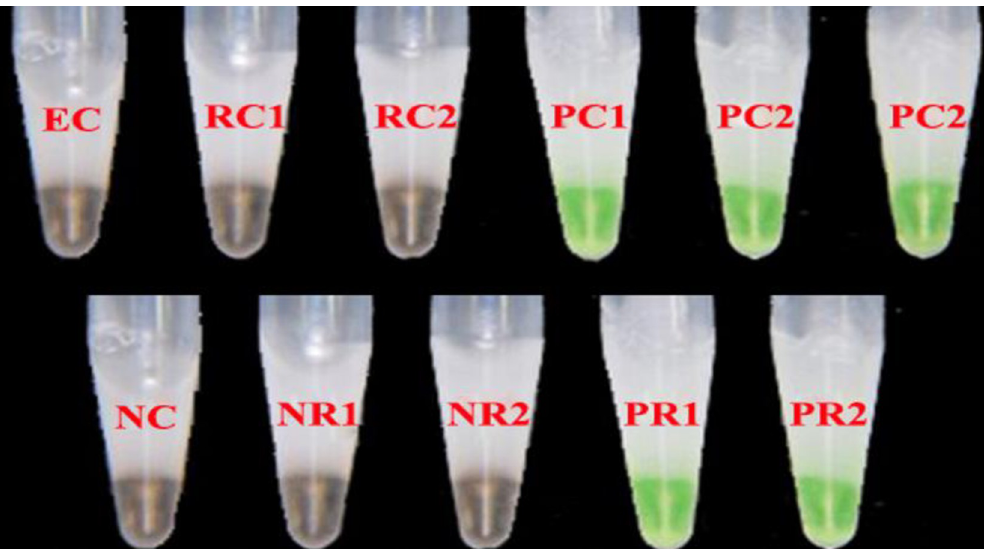
Fig 1. Quality control of LAMP assay. EC–extraction control, RC1 –reaction control (master mix), RC2—reaction control: master mix with nuclease free water, PC 1 –positive control (24,087 parasites/ μ L), PC2—positive control (812 parasites/ μ L), PC3—positive control (6 parasites/ μ L), NC–negative control, NR1/2 –patient negative reactions, PR1/2 –patient positive reactions.